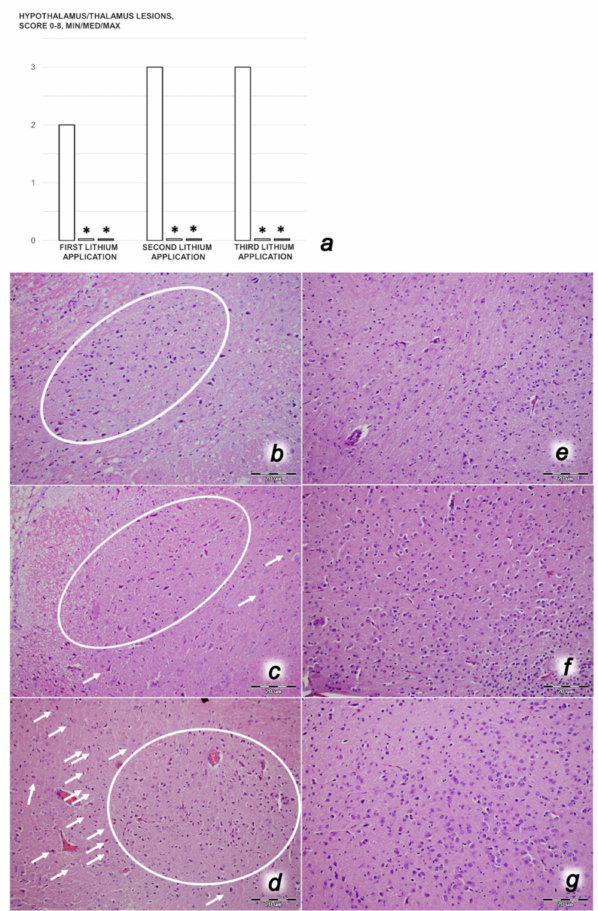
Figure 16. Brain pathology. Neuropathological changes of the hypothalamus. ( a ) Semiquantitative neuropathological scoring system of the lesions of the hypothalamus in the lithium-treated rats after the first, second, and third lithium administration (500 mg/kg/day intraperitoneally for 3 consecutive days). BPC 157 10 µ g/kg (light gray bars), 10 ng/kg (dark gray bars); saline 5 mL/kg (white bars) given intraperitoneally after each of the three lithium administrations. Six rats/group/interval. Min/Med/Max, * p < 0.05, at least vs. control. In control rats, a continuous increase in the rate of affected area occurred, from grade 2 (up to 50 percent of hypothalamus cortex area affected with a patchy karyopyknotic areas) after the first lithium administration, to grade 3 (up to 75 percent of hypothalamus cortex area affected with more extensive of) after the second and third lithium administrations, whereas in BPC 157-treated rats no neuronal changes were found. Hypothalamus histology ( b – g ). Control ( b , d , f ), BPC 157 ( c , e , g ); first lithium application ( b , c ), second lithium application ( d , e ), and third lithium application ( f , g ). A marked karyopyknosis of hypothalamic neurons (circles and arrows) presented in the control lithium-treated rats after each of the lithium administrations. In contrast, BPC 157-treated rats showed a normal structure of the hypothalamus (HE; magnification × 200, scale bar 20 µ